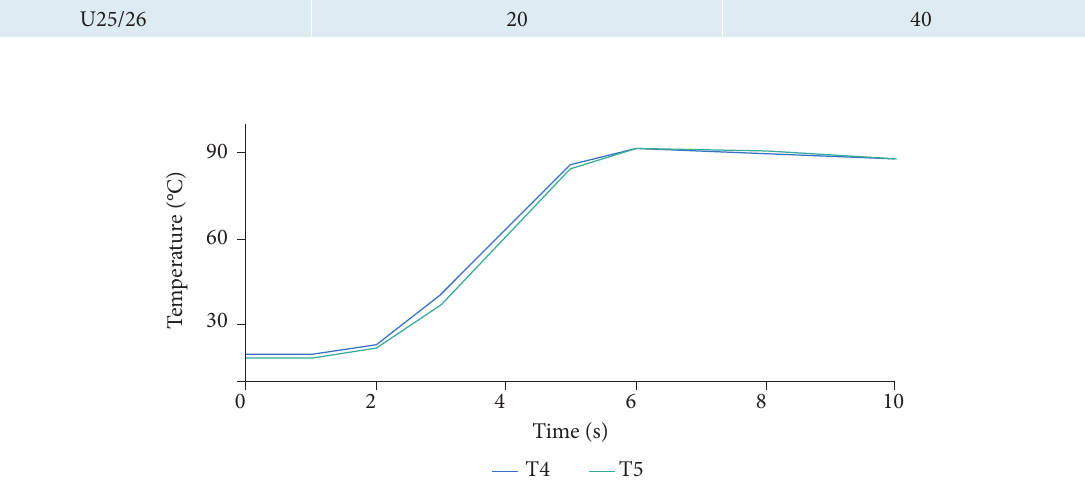
Figure 10. Experimental temperature data of a) T4 and b) T5 for NRB25.